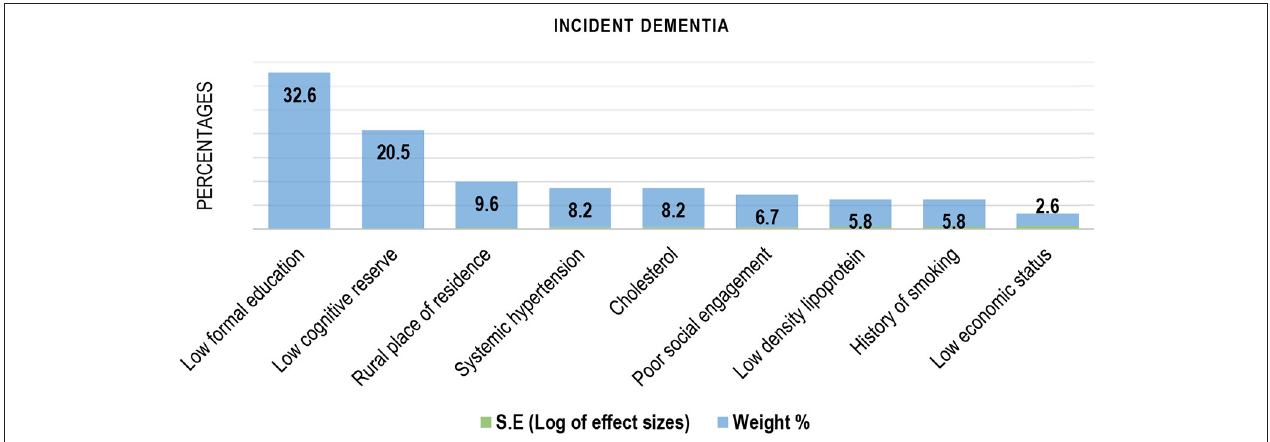
FIGURE 4 | Modifiable risk factors for Incident dementia in Sub-Saharan Africa (ranked by the inverse of variance